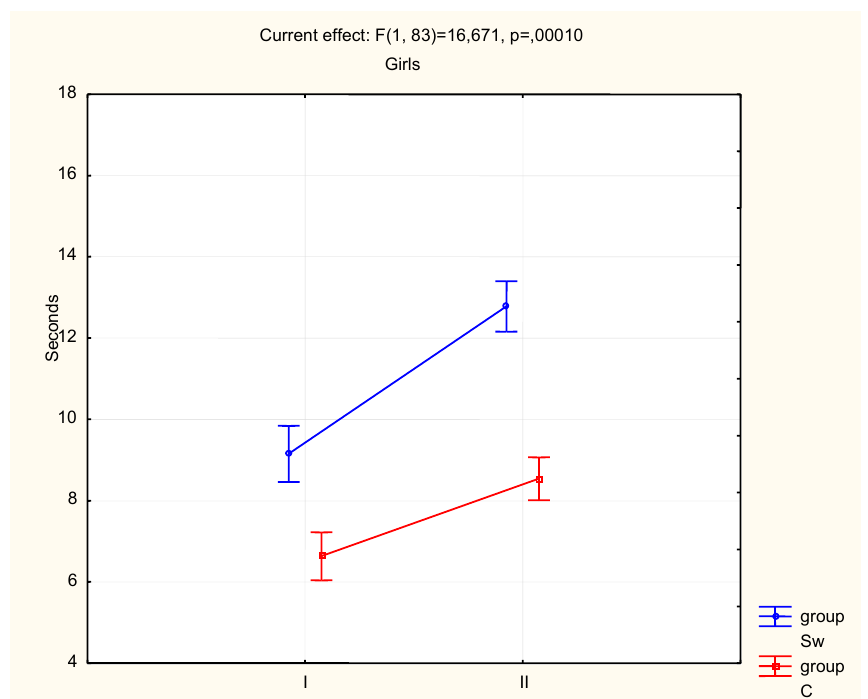
Fig 7. Changes of Bent Arm Hang Test (functional strength) results in the Swimmers (Sw) group and Control (C)